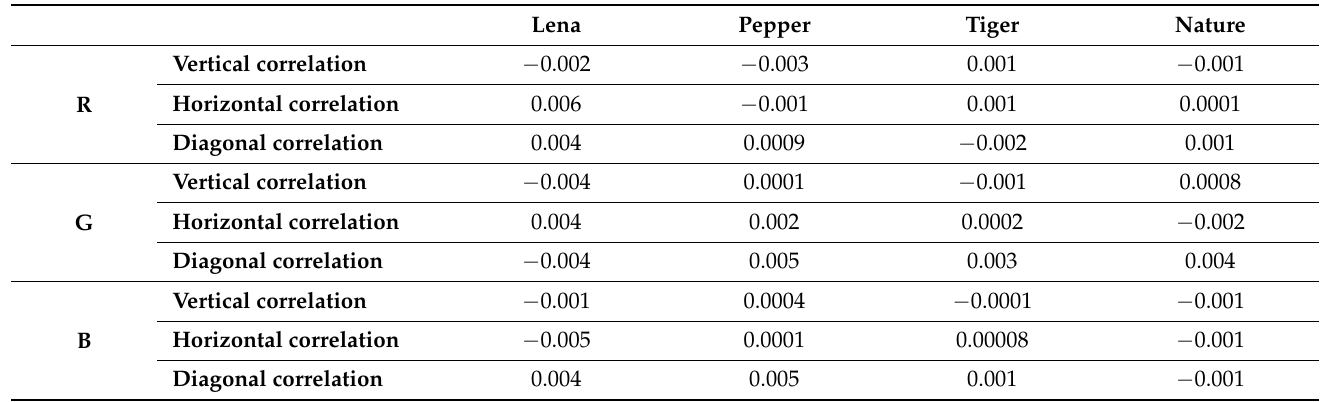
Table 6. The different correlation coefficients of the R, G, and B cipher images.